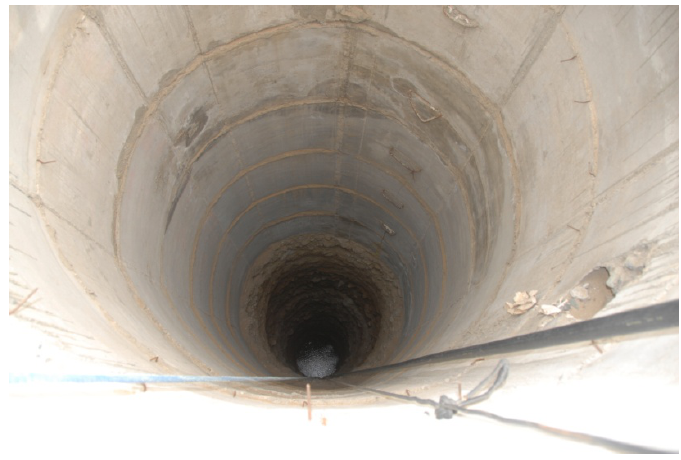
Figure 2. Two-meter diameter well showing the water level at about 20 m below surface in Wadi Qidayd, western Saudi Arabia.